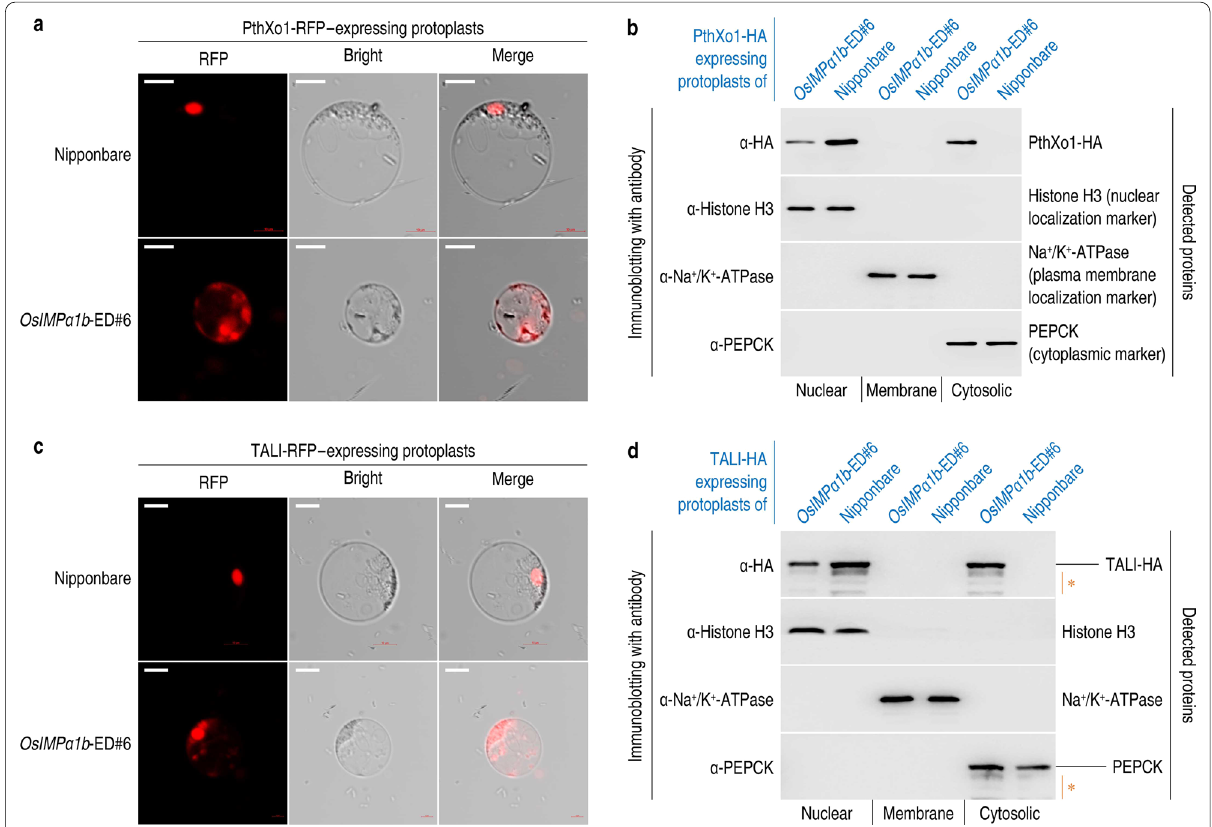
Fig. 5 Protoplast fluorescence images and Immunoblotting (IB) analyses showing differences in subcellular localization of the TALEs between the WT (Nipponbare) and OsIMPα1b -ED#6 plants. a Laser scanning confocal microscopy (LSCM) images of the plant protoplasts at 16 h after transformation with the pthXo1-RFP fusion gene. Each image is representative of 200–300 protoplasts. b IB of proteins extracted from protoplasts equivalent to those in a . c LSCM images of the plant protoplasts at 16 h after transformation with the TALI-RFP fusion gene. In a and c , each image is representative of 200–300 protoplasts; scale bars 10 µm. d IB of proteins extracted from protoplasts equivalent to those in c . The asterisks and = vertical lines indicate unidentified cross-reactive